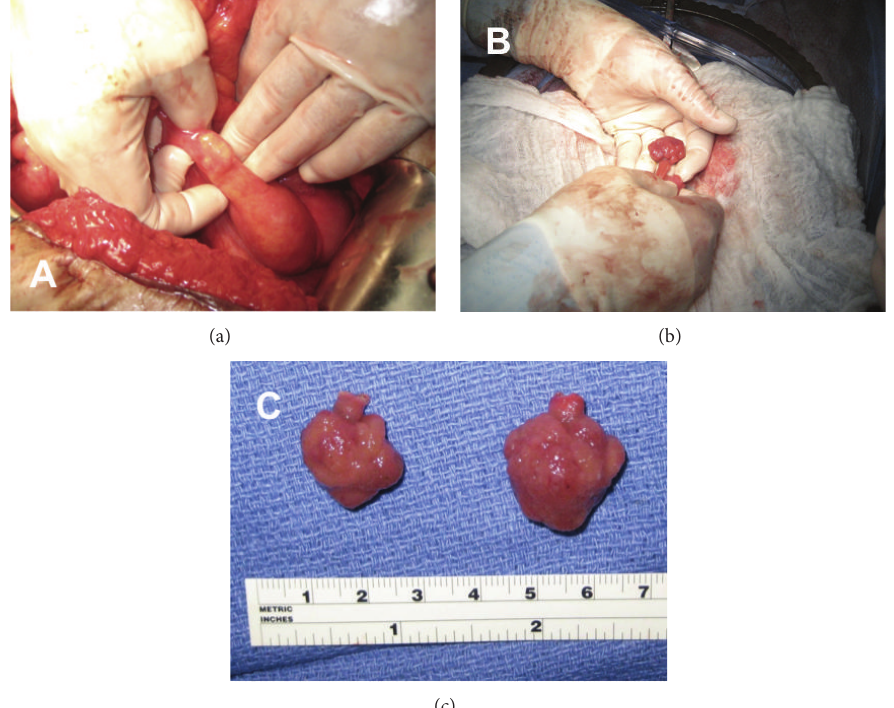
Figure 6: Intraoperative palpation of small bowel delineating the position of the hamartomatous polyps (a). A polyp, immediately prior to excision (b). Two Peutz-Jeghers polyps after excision